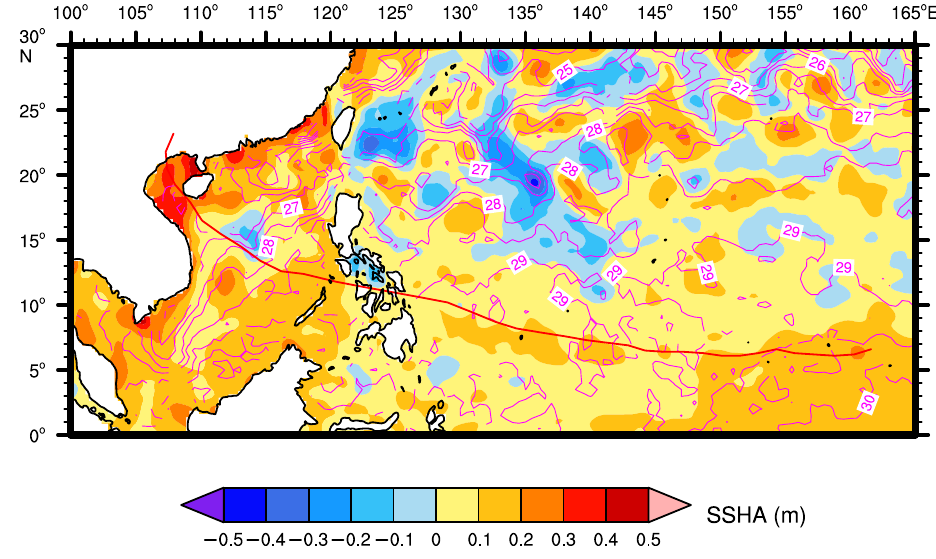
Figure 3. Sea surface height anomaly during super-typhoon Haiyan (color shading), the sea surface temperature (contour), and the best track data (thick red